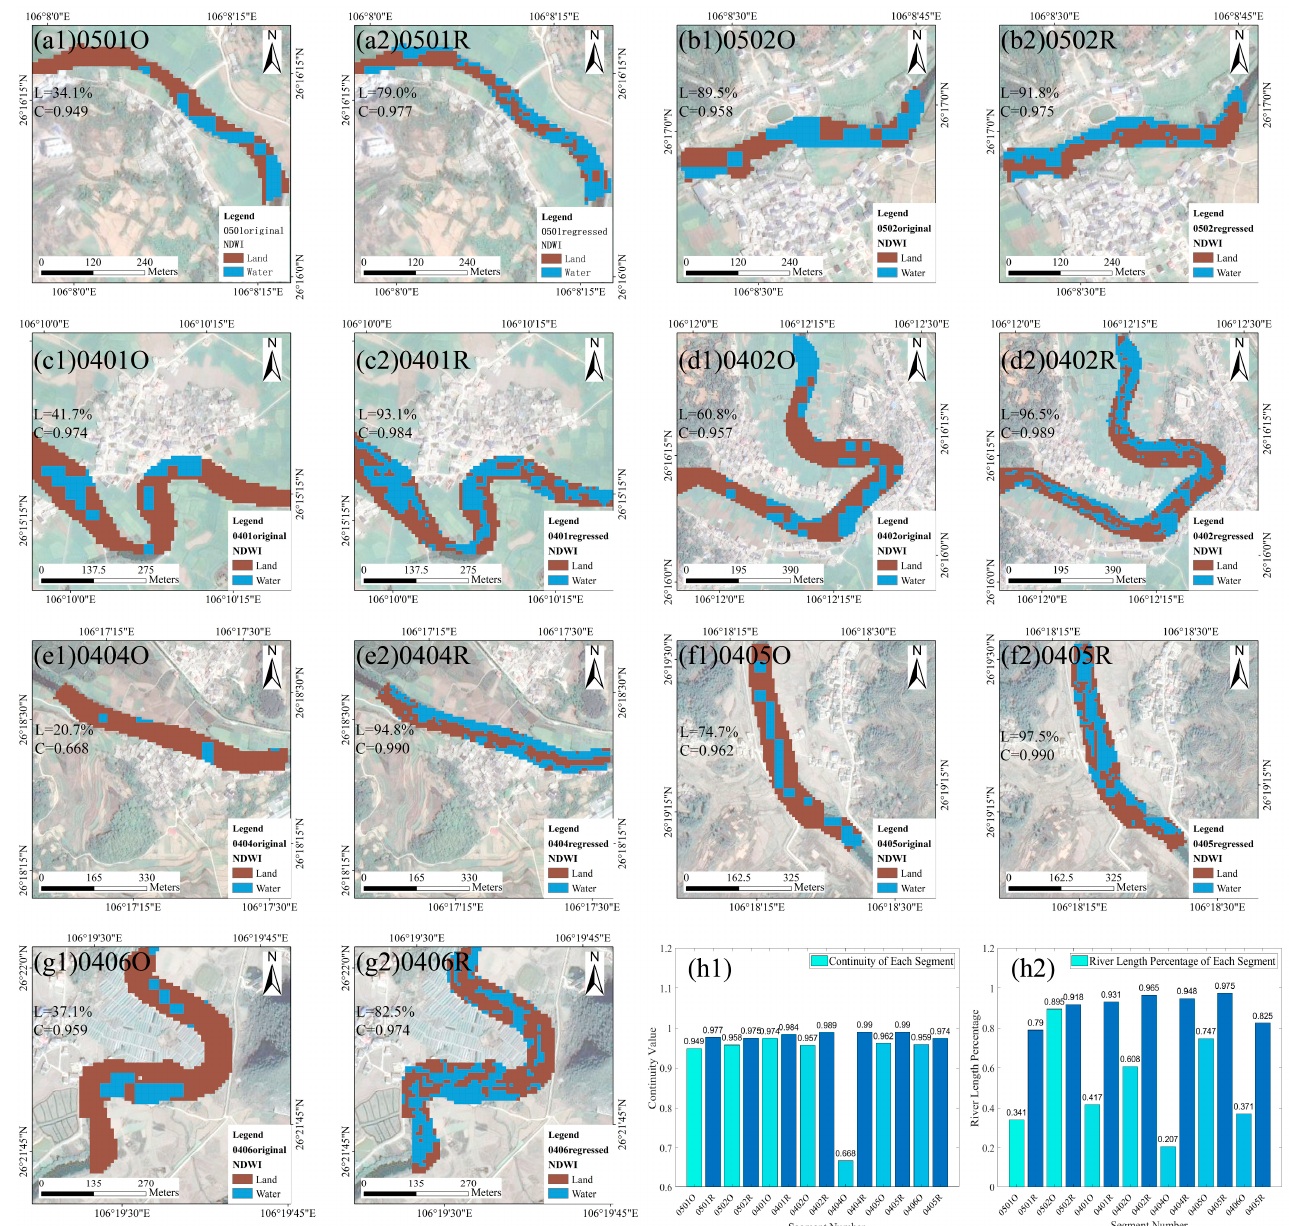
Figure 2. Water recognition distribution from original and regressed LS8 images. Figures ( a – g ) represent the water body distribution in the map before and after the method was applied to segments 0501, 0502, 0401, 0402, 0404, 0405 and 0406. In each group, 1 represents the original image, 2 represents the regressed image. Group h represents the statistical variation of seven segments in two parameters: continuity ( h1 ) and river length percentage ( h2 ). Bars in light blue represent original images, bars in dark blue represent regressed